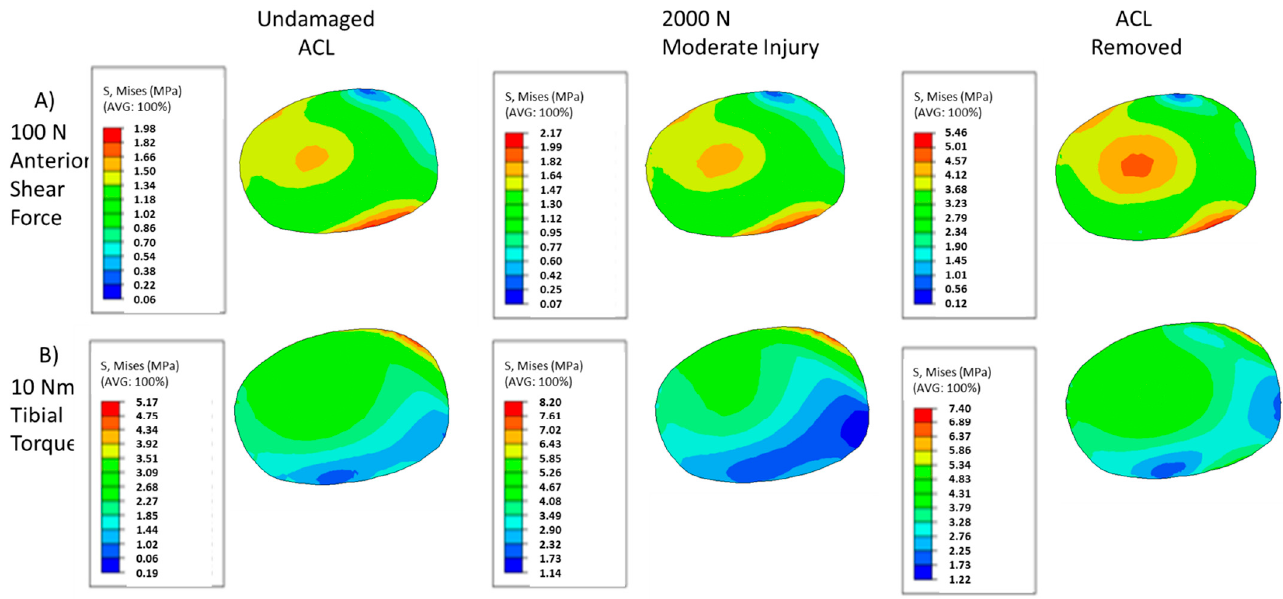
Figure 6. Contour plots of PCL mid-substance von Mises stress (MPa). ( A ) Contour results for at 100 N anterior shear force on the tibia for undamaged, moderate injury, and complete ACL destruction. ( B ) Contour results for at 10 NM tibial torque on the tibia for undamaged, moderate injury, and complete ACL destruction.